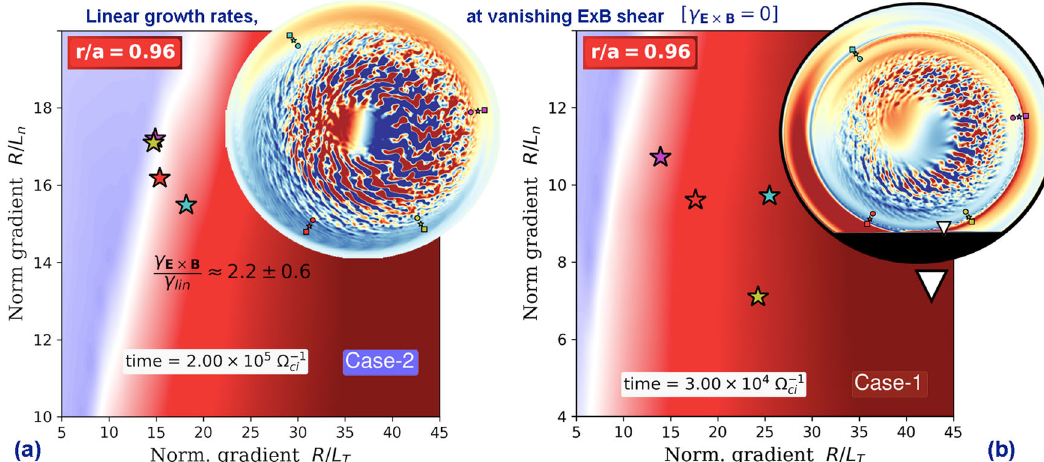
Fig. 7 Without plasma-wall interplay, the outer edge is linearly stable. Linear stability analysis is computed at vanishing E × B shear and at radial locations r / a = 0.9, 0.96, and 1.02 for the poloidally symmetric fl ux-driven Case-2 ( a ) and the fl ux-driven limited Case-1 ( b ). Linear stability of gradient- driven Case-3 is comparable to that of Case-2. Stability at r / a = 0.96 is displayed yet all three radial locations provide a qualitatively comparable picture. The following four poloidal locations are shown: θ k = {9 ∘ (magenta), 126 ∘ (cyan), − 118 ∘ (red), − 61 ∘ (yellow)}. A fi fth one is shown ( b ) at angle θ = − 75 ∘ (white triangle). These locations are also marked in Fig. 1. The outer edge r / a ≥ 0.9 is linearly stable without limiter ( a ) at all times (shown here at statistical equilibrium ( t Ω ci = 200,000)), despite modest core ➝ edge turbulence spreading, illustrated in Fig. 4. Conversely, the outer edge is driven interchange-unstable (b) by the presence of the limiter on fast time scales ( t Ω ci = 30,000). This drive endures at later times ( t Ω ci = 250,000), emphasising robust and steady free energy injection from plasma--boundary computations, run on Tier-0 Joliot-Curie at GENCI@CEA and MareNostrum at (Case-1) con fi gurations are estimated in GKW . The salient conclusions are as follow, Barcelona Supercomputing Centre, we assume a reduced magnetic fi eld on axis: with details further provided in ref. 37 : in poloidally symmetric Case-2 and Case-3, B 0 = 1.7T, which amounts to computing a plasma column of slightly smaller size GKW fi nds the edge to be marginally stable at vanishing E × B shear: γ lin ≈ 0. ρ ⋆ = 1/300 on a 1/4 wedge torus with ( r , θ , φ , v ∥ , μ ) = (512, 1024, 64, 128, 64) grid. Inclusion of E × B shear γ E would predict the edge to be nonlinearly uncondi- The robustness of the reported main results (observed gradient anisotropy and tionally stable past r / a ≥ 0.9, with γ eff = γ lin − γ E < 0 at all poloidal locations. magnitudes in the limited con fi guration) are robust whilst varying distribution Analysis with a kinetic trapped electron response provides the same stability assessment for r / a ≥ 0.9. The situation in Case-1, with the presence of a limiter function initialisation, presheath values in the SOL, penalised temperature T w , dramatically changes. A poloidally localised instability at t Ω ci = 30,000 arises about limiter shape. A shortfall is robustly found without limiter, even when considereing θ = − 61 ∘ (yellow), dominantly of interchange character whilst the midplane variations in T e / T i ratio, safety factor q , magnetic shear s and density gradient. k θ = 9 ∘ remains linearly stable. Further details are given in ref. 37 . These results are reported in detail elsewhere 37 . k Causal inference . The following vorticity equation can be inferred from the pri- Linear stability analysis . Linear stability analysis of the poloidally symmetric and mitive gyrokinetic equations including E × B drift and FLR at leading order: limited GYSELA pro fi les is performed using the initial value framework of the GKW code 12 , based on the gradient-driven and local ( fl ux-tube) approximations. A typical example is shown in Fig. 7. Growth rates for the most unstable poloidal wavenumbers k θ ρ i = 0.6 in poloidally symmetric (Case-2 and Case-3) and limited